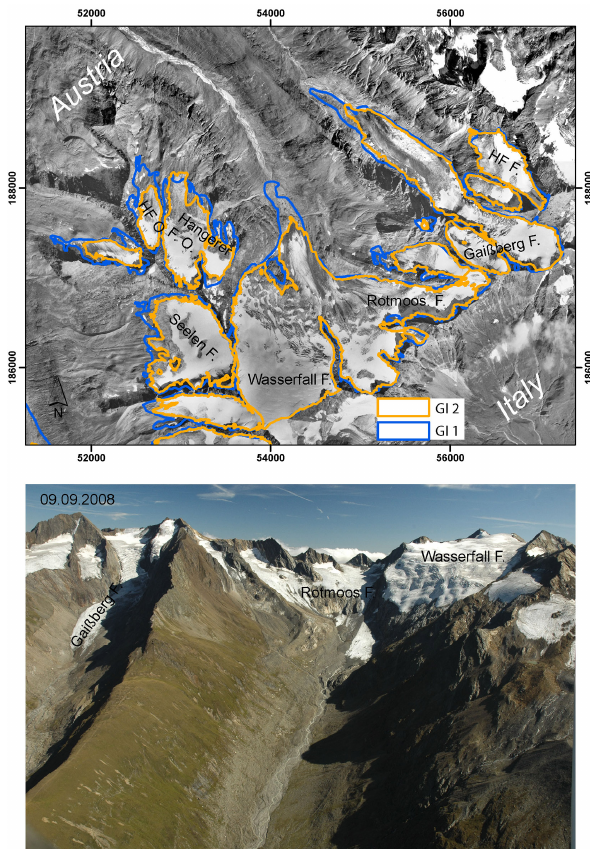
Figure 2. GI 1 and GI 2 glacier margins superimposed on a GI 2 orthophoto with an oblique photograph of the area in the Ötztal Alps. HF O: Hangerer Ferner Ost; HF F: Hochfirst